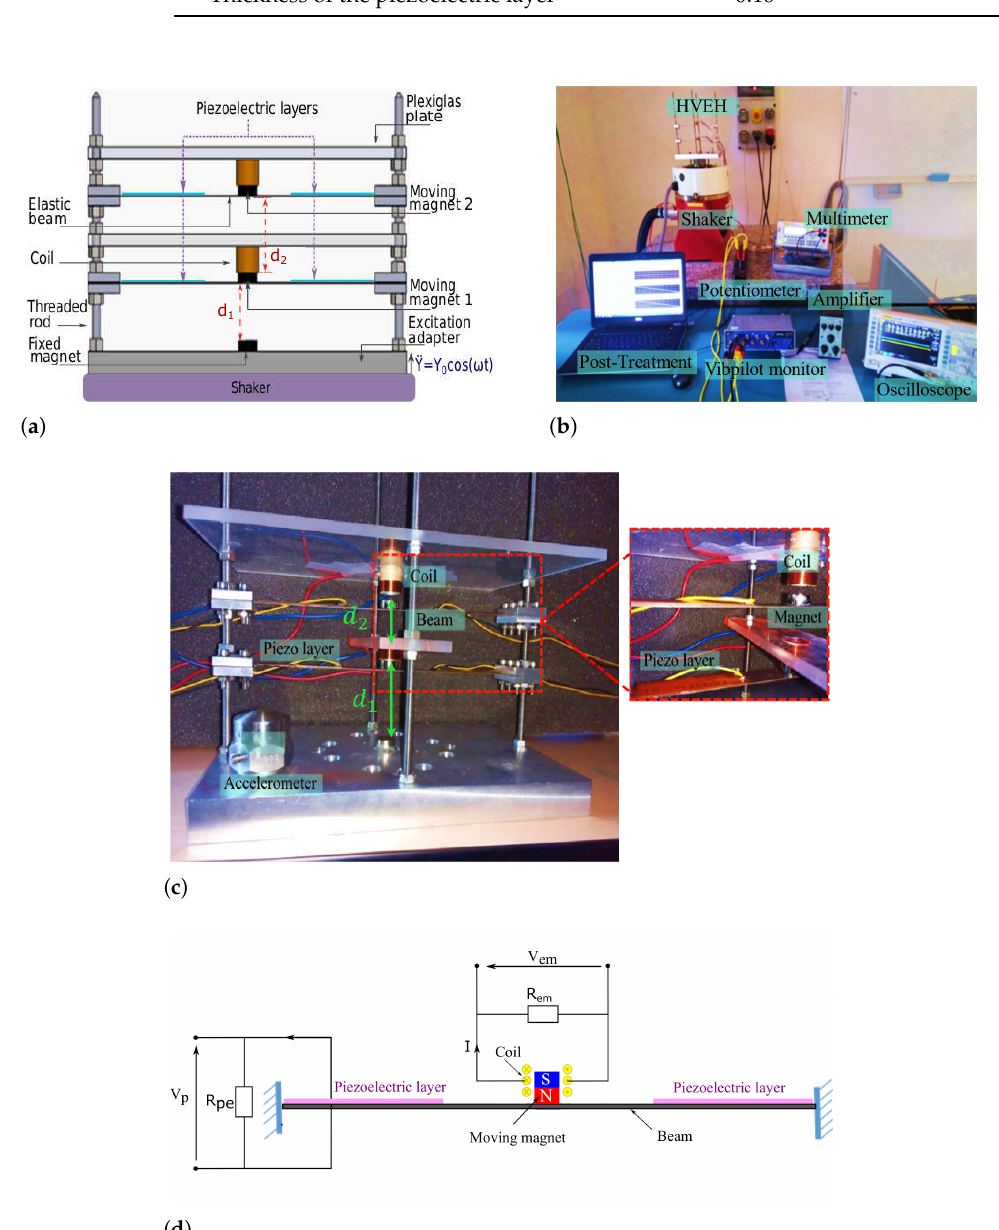
Figure 1. ( a ) The proposed hybrid energy harvester destined to activate the internal resonance phenomenon; ( b ) the experimental setup; ( c ) the proposed hybrid vibration energy harvester (HVEH); ( d ) circuit of the tested piezoelectric V p and electromagnetic voltages V em of the hybrid energy harvesting